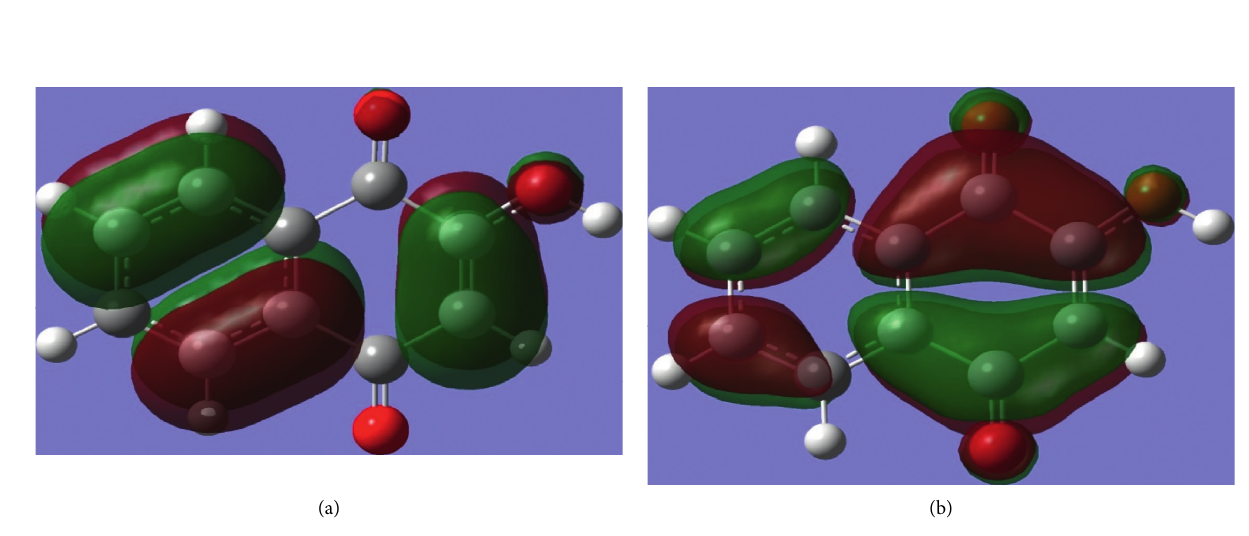
Figure 23: The HOMO and LUMO of lawsone.